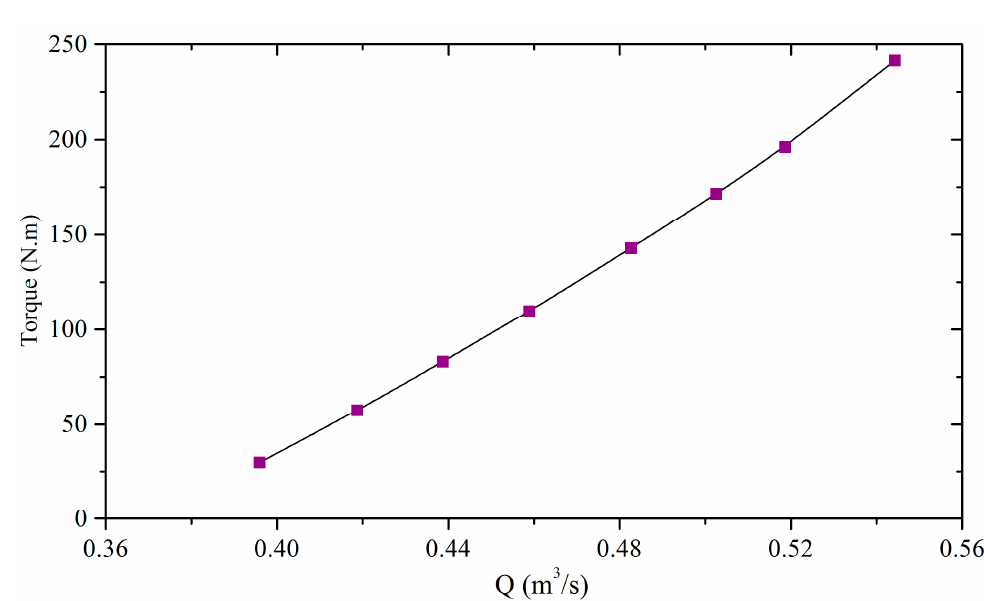
Figure 7. Model units.